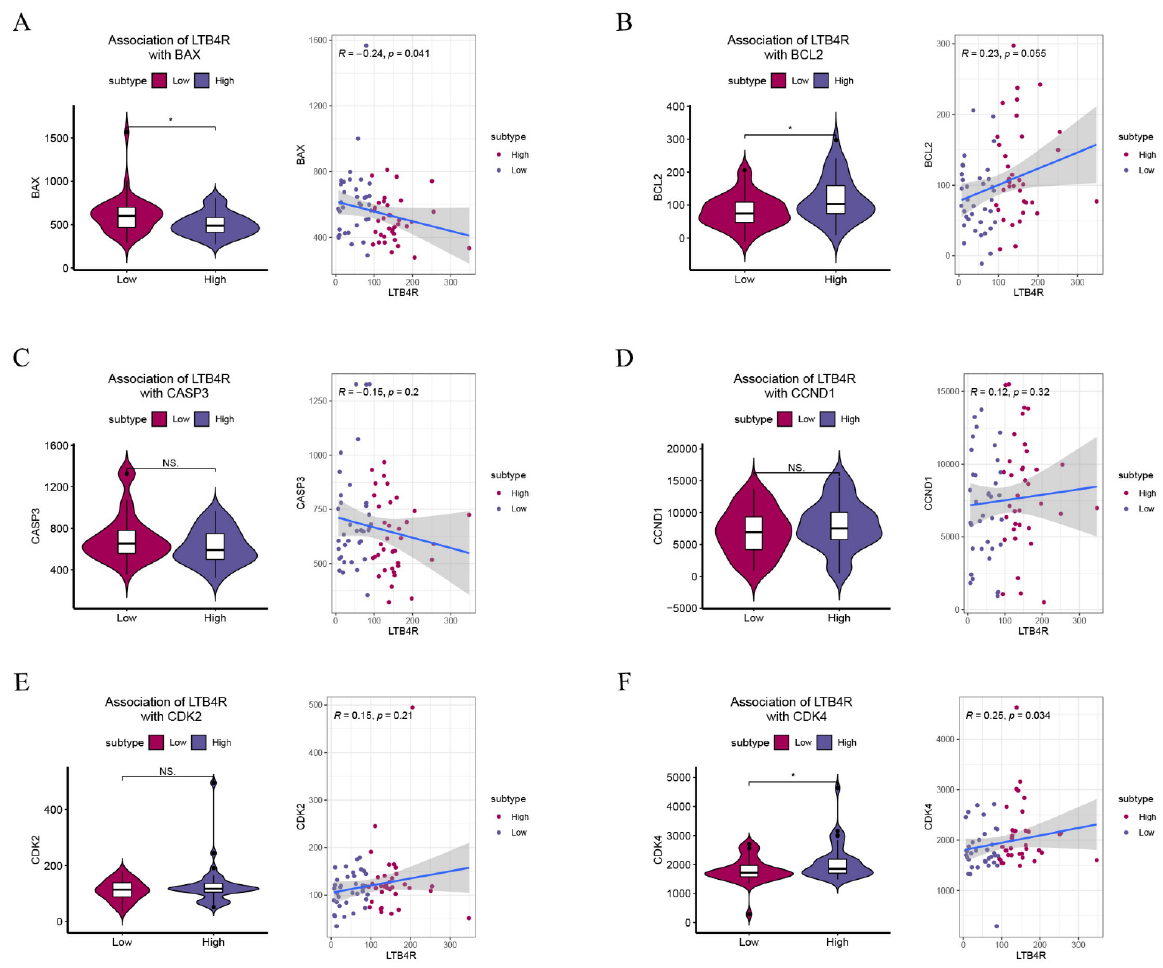
Figure 7. The association of LTB4R with BAX, BCL2, CASP3, CCND1, CDK2, and CDK4. ( A – F ) The difference of BAX, BCL2, CASP3, CCND1, CDK2, and CDK4 scores defined by using ssGSEA between LTB4R high expressed group and LTB4R low expressed group. In addition, the association of LTB4R expression with BAX, BCL2, CASP3, CCND1, CDK2, and CDK4 scores. Wilcoxon rank-sum test, * p < 0.05.